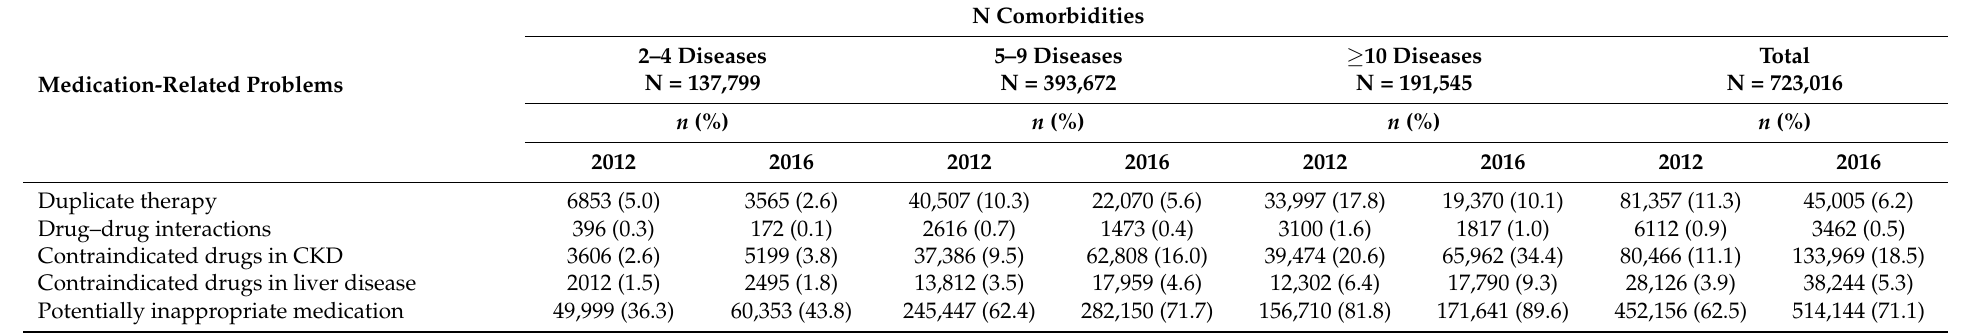
Table 2. Medication-related problems in older people by multimorbidity group at baseline and at the end of the study (N = 723,016).